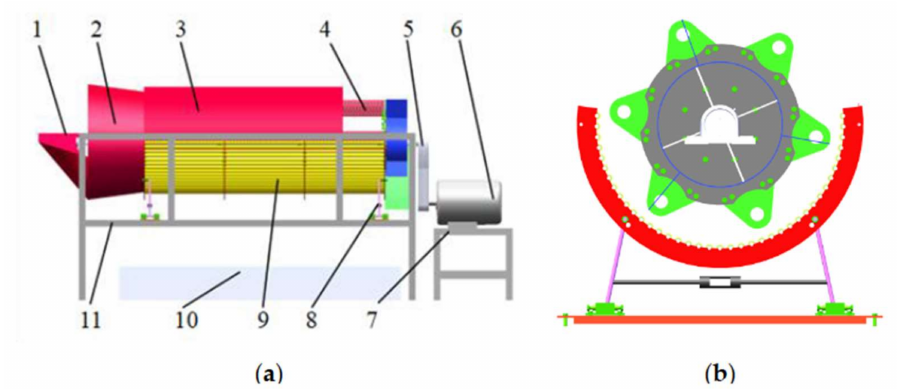
Figure 1. Structural diagram of longitudinal axial flow staggered millet threshing device: 1. feed inlet; 2. conical spiral feed housing; 3. top cover; 4. staggered threshing drum; 5. drive belt; 6. variable frequency motor; 7. motor support; 8. concave screen micro motion support device; 9. rotary tubular concave screen; 10. receiving box; 11. frame. ( a ) Assembled frame; ( b ) schematic diagram of combination of “staggered teeth” threshing drum and micro rotating circular tubular concave